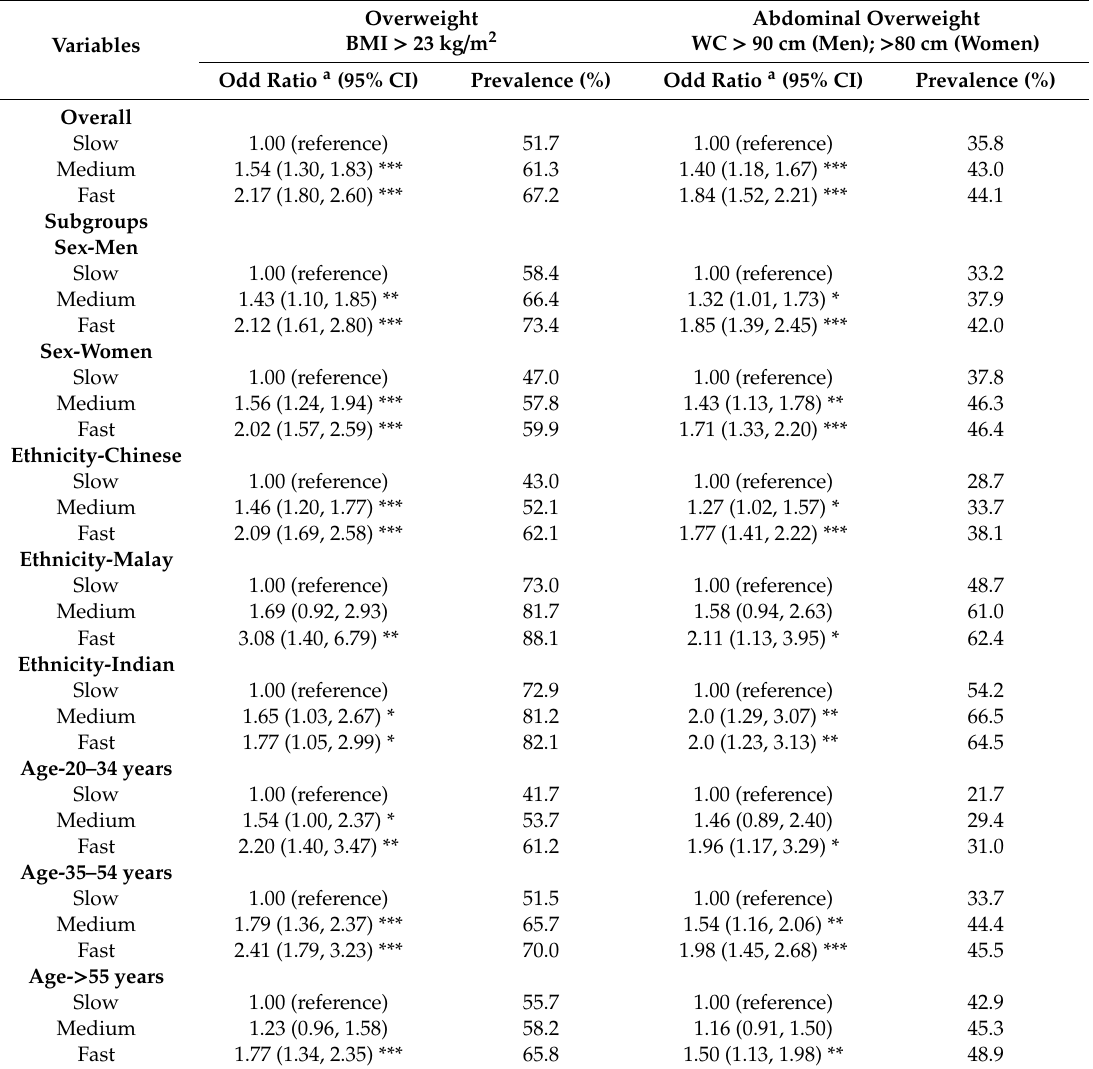
Table 3. Multivariable logistics models of odd ratios (ORs) for being overweight, assessed by BMI and waist circumference (WC) according to self-reported eating rate (SRER) in the Singapore Multi-Ethnic Cohort 2, by sex, ethnic, and age groups. Abdominal Overweight Overweight WC > 90 cm (Men); > 80 cm BMI > 23 kg / m 2